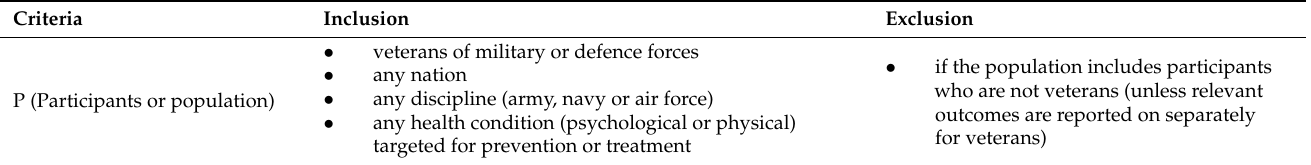
Table 1. PICOS study eligibility